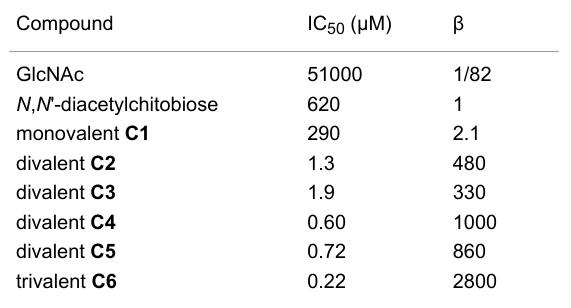
Table 2: Absolute and relative IC 50 values of synthetic ligands C1 – C6 for inhibition of the binding of HRP-labeled WGA to covalently immobi- lized GlcNAc from dose-response curves shown in Figure